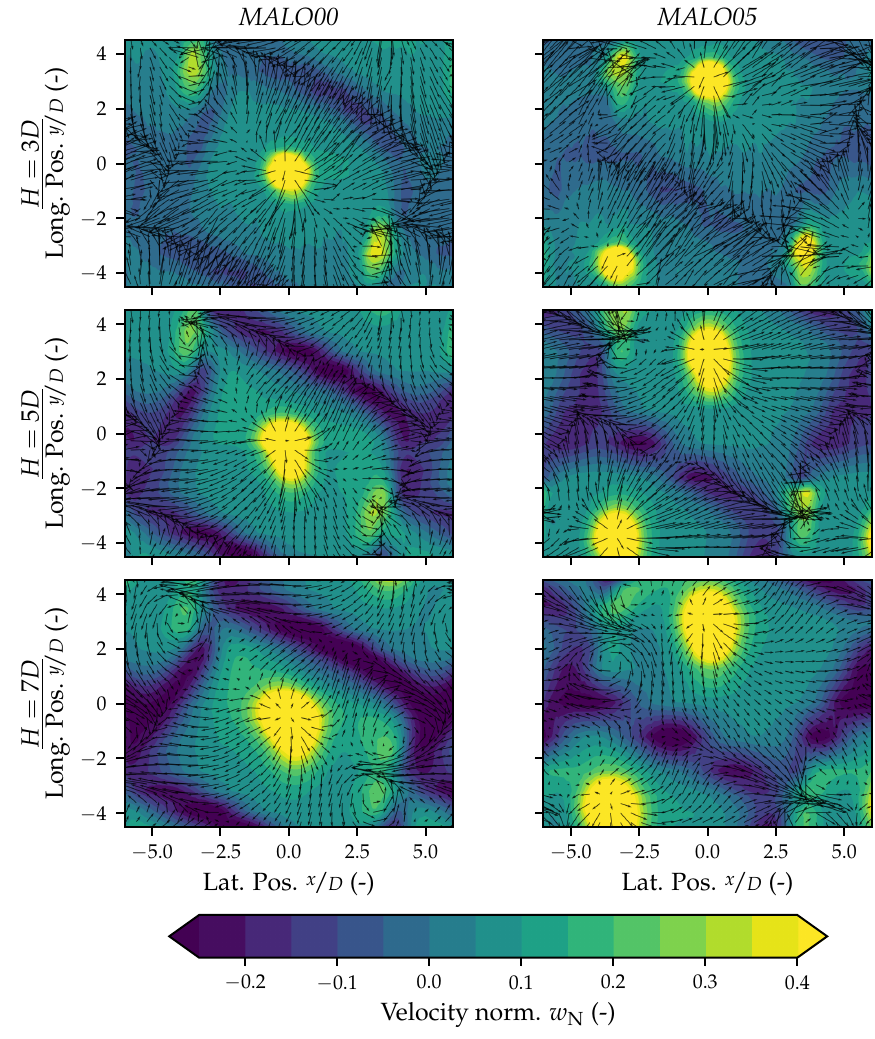
Figure 6. Cavity flow, low Reynolds number Re D ≈ 10 × 10 3 . w -velocity normalized shown at z -normal plane with H ∗ = 80%. Vectors show planar velocity components, unit length vec ul = 3. Rows show cavity height, columns show